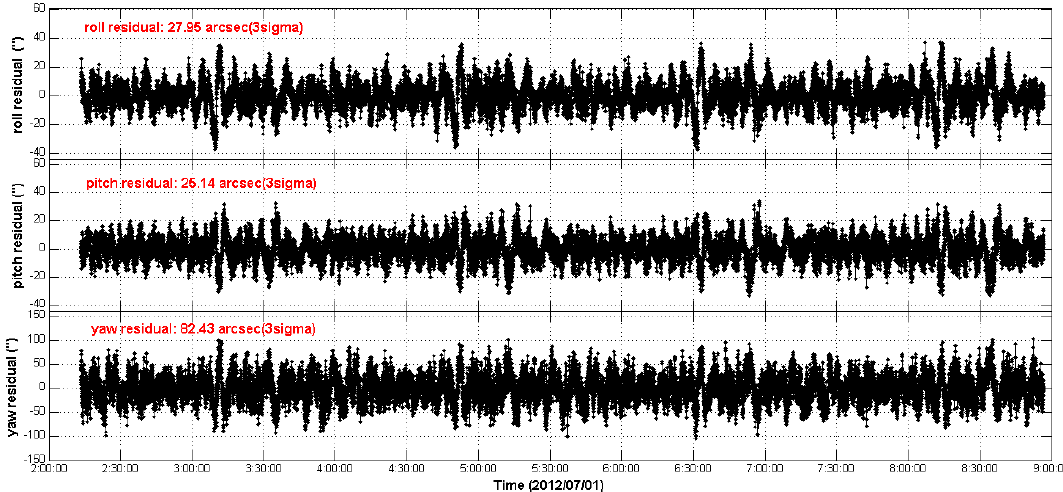
Figure 10. The relative Euler angle residual streams as time series (without LFE compensation).